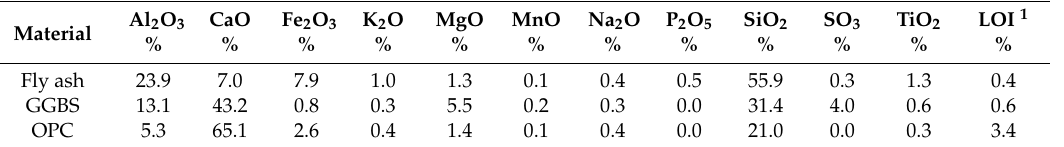
Table 1. Oxide compositions of fly ash, ground granulated blast-furnace slag (GGBS) and ordinary Portland cement (OPC).